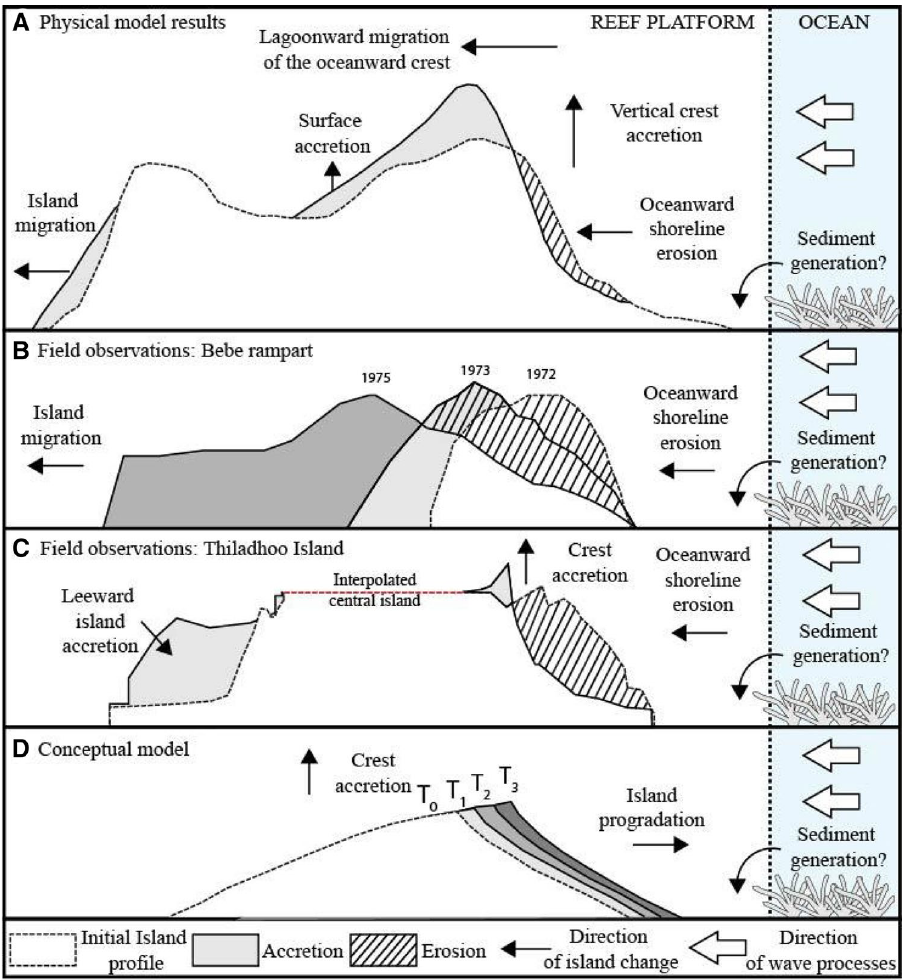
Figure 3. A conceptual model of island response to changing boundary conditions with a sediment supply observed in ( A ) the wave flume, ( B , C ) Field observations 30,32 , and ( D ) conceptual model 7